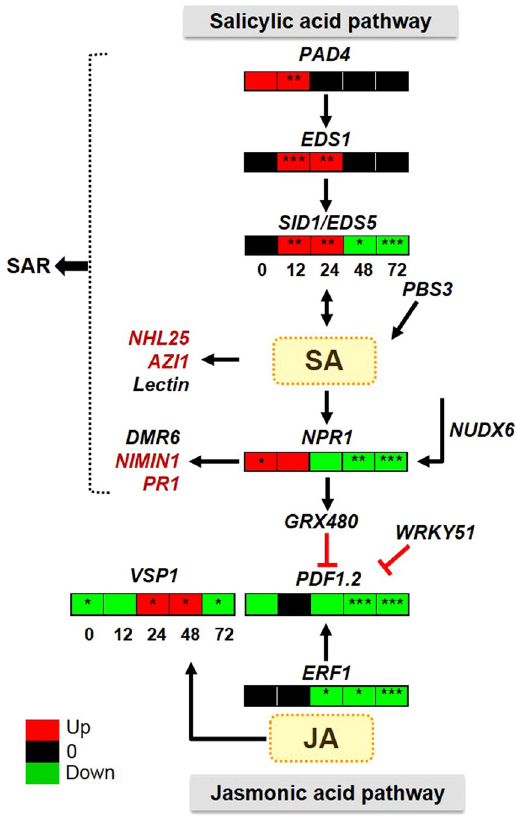
Figure 7. Expression pattern of the genes involved in SA- and JA-defense signaling pathways. Expression patterns are shown in colored panel where red, green, and black colors indicate transcript levels with induction, reduction and no-difference, respectively based on qRT-PCR results (Supplementary Fig. S3). The boxes within a panel indicate the expression levels of each gene in SV-treated plants compared to control during 0 to 72 h post infection (hpi). The genes marked in red color are based on the microarray results (Table 1). Pointed arrows indicate activation and blunt arrows indicate repression. All experiments were performed with three biological replications. P -value ranges are marked by asterisks: *** P < 0.01, ** 0.01 < P < 0.05, * P <